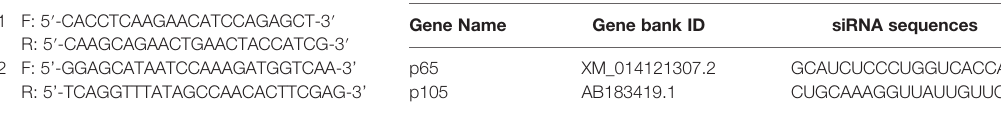
TABLE 2 | Sequences for the transfection of small interfering RNA